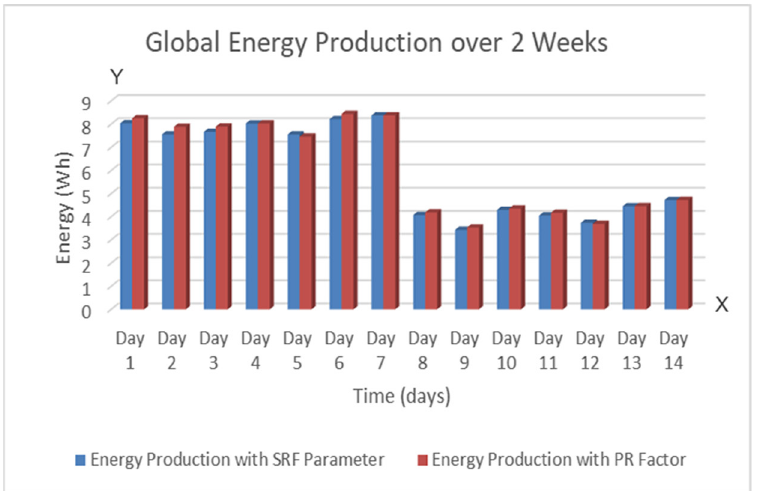
Figure 9. Global Energy Production Computation of the Solar Tracking Device using the SRF Parameter (blue bar) and PR Factor (red bar).